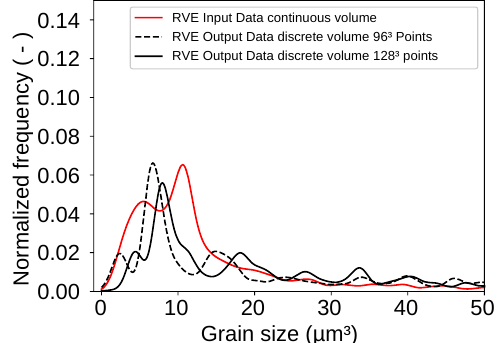
Figure 12. Log probability density of the input values as well as the output values for an RVE created with 128 × 128 × 128